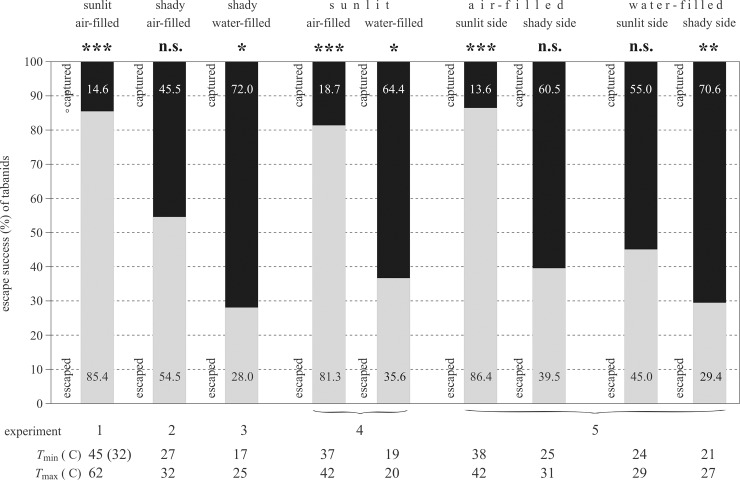
Escape success of horseflies in experiments 1–5.Surface temperature range Tmin ≤ T ≤ Tmax of barrels and the proportion of escape success of tabanids (grey bars) that landed on the barrels under different illumination and thermal conditions in experiments 1–5 (S6–S10 Tables). The results of χ2 test are indicated: n.s: not significant, p > 0.05, *: 0.01 < p < 0.05, **: 0.001 < p < 0.01, ***: p < 0.001 (S5 Table). Grey and black bars illustrate the escape and capture rates, the proportion values of which are given in the columns.